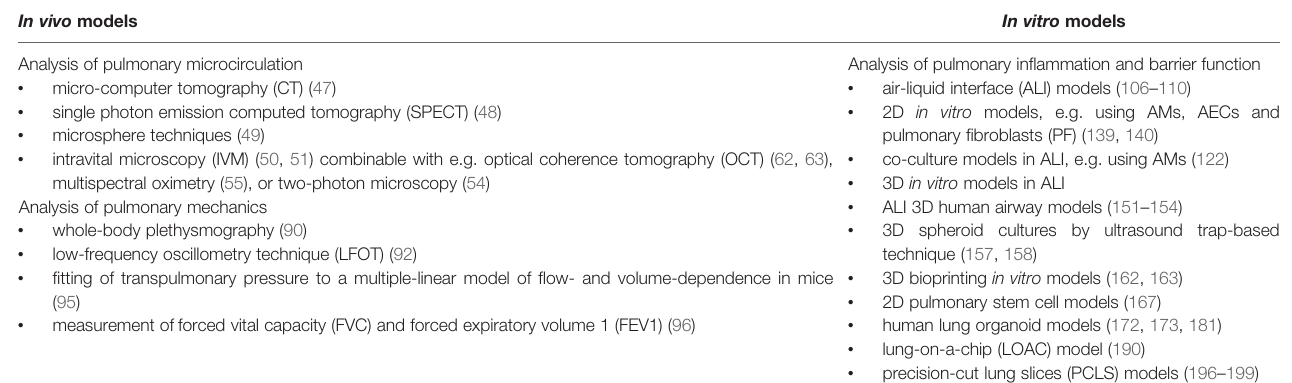
TABLE 1 | In vivo and in vitro models of pulmonary barrier to study acute in fl ammatory diseases. In vivo models In vitro